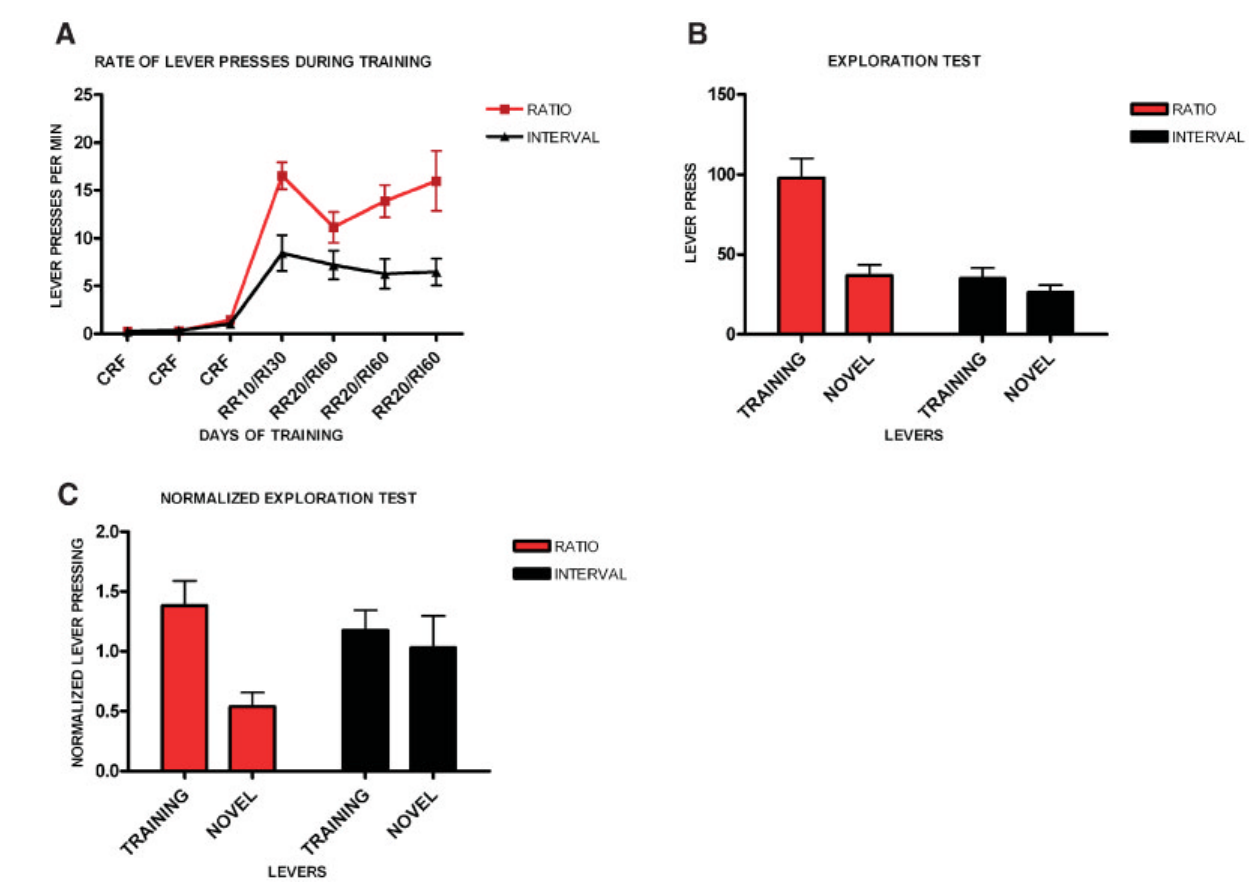
Figure 4. Different schedules of reinforcement produce different predisposition for exploration versus exploitation in C57B16/J mice . ( A ) Acquisition of the lever-pressing task in animals trained on random ratio and random interval schedules. The rate of lever pressing (per minute) for each daily session is depicted. ( B ) Absolute number of lever presses on the training lever versus a novel lever for the different training schedules. ( C ) Lever pressing on the training lever versus a novel lever normalized to the lever pressing of the last day of training.